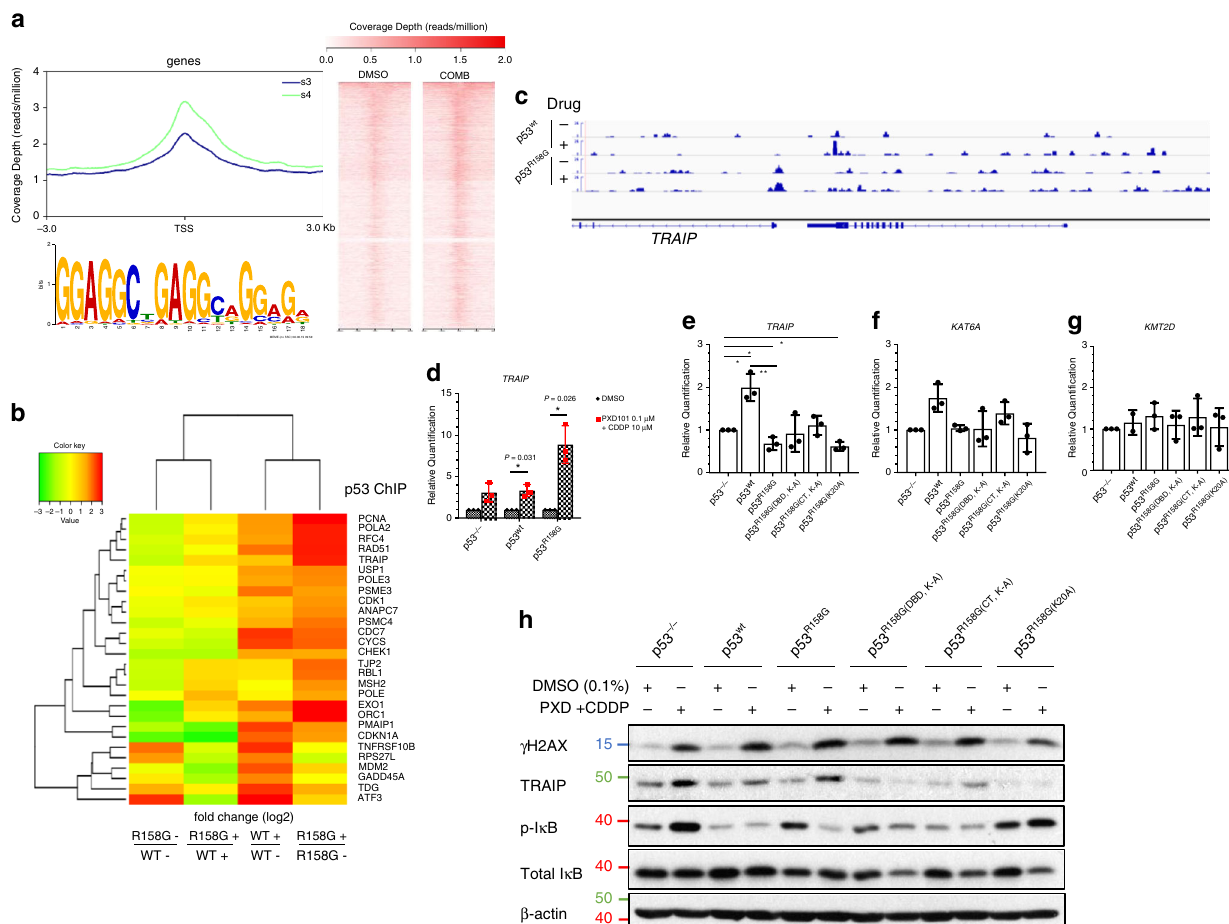
Fig. 5 Genome-wide binding and downstream transactivation of GOF p53 R158G . a mutp53 R158G -binding loci identi fi ed by p53 ChIP-seq analysis on Calu-1 cells treated with vehicle or belinostat/cisplatin combination for 24 h ( n = 1). Meta-peak analysis showing distribution of p53 R158G -binding sites across 3000 bp from the TSS of the nearest downstream gene (left, top). Density heatmap of the mutp53-binding sites (±3000 bp from TSS) examined by ChIP- seq (Right). Canonical wild-type p53 consensus motif was identi fi ed by MEME/TomTom from the TSS-proximal ChIP-Seq peaks (bottom left). b Comparisons of the transcriptomic levels of differentially-expressed genes (AmpliSeq analysis) bound by p53 (ChIP-seq analysis) under vehicle ( − ) or drug-treatment ( + ) conditions. Colors from green to red indicate increasing RNA level (fold change as indicated) in each pair. Individual fold change values were tabulated in Supplementary Table 4. c Integrative Genomics Viewer display of mutp53 occupancy over promoter region of TRAIP gene in vehicle- or drug-treated cells (p53 wt , p53 R158G ). d RT-qPCR quanti fi cation of TRAIP gene in Calu-1 (p53 − / − , p53 wt , p53 R158G ) cells 48 h after vehicle or drug treatment. e – g RT-qPCR analyses of the basal mRNA levels of TRAIP ( e ), KAT6A ( f ) and KMT2D ( g ) in various p53 clones, compared to p53 − / − . Data are represented as average relative quanti fi cation ± SD ( n = 3 independent experiments). Two tailed Student ’ s t -test; * P < 0.05; ** P < 0.01. h Immunoblotting was performed to evaluate the effects of belinostat/cisplatin on the indicated targets in various p53 clones. β -actin shown as loading control ( n = 3 independent